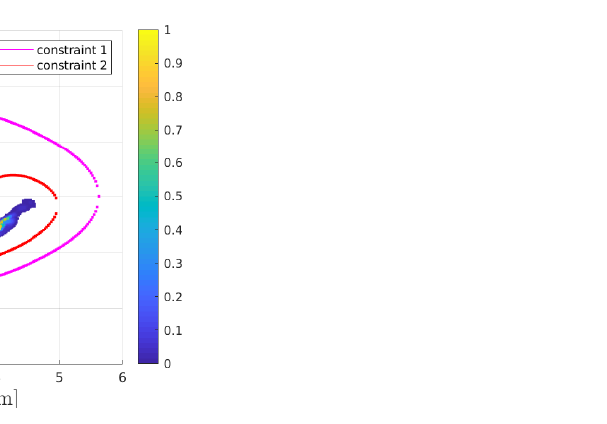
Figure 2. ( s , ˙ s ) PAR weighted particles for satnum = 337. Colors represent p ( a , e ) as indicated by the color bar. Note that in white are particles for which γ is lower than a minimum acceptable